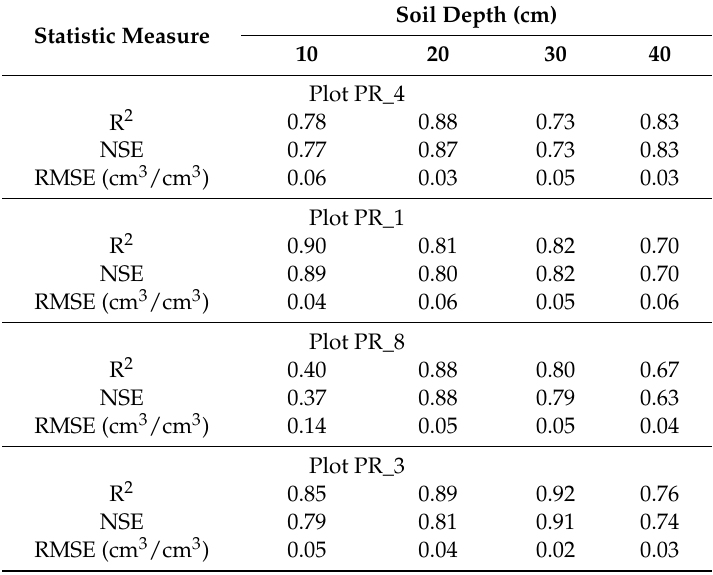
Table 2. Statistical measures of the Hydrus-1D model performance for simulations of soil moisture content at the riparian zone after calibration.